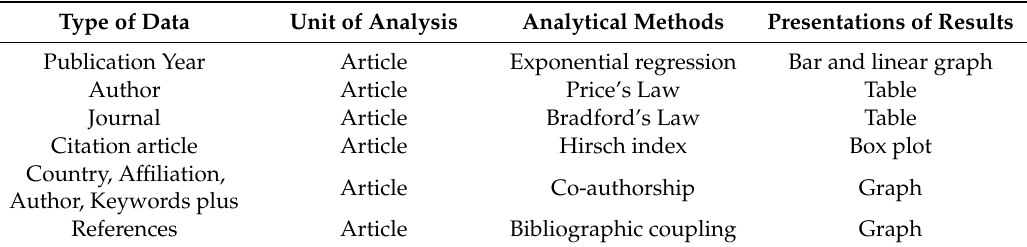
Table 1. Type of data, methods and results.